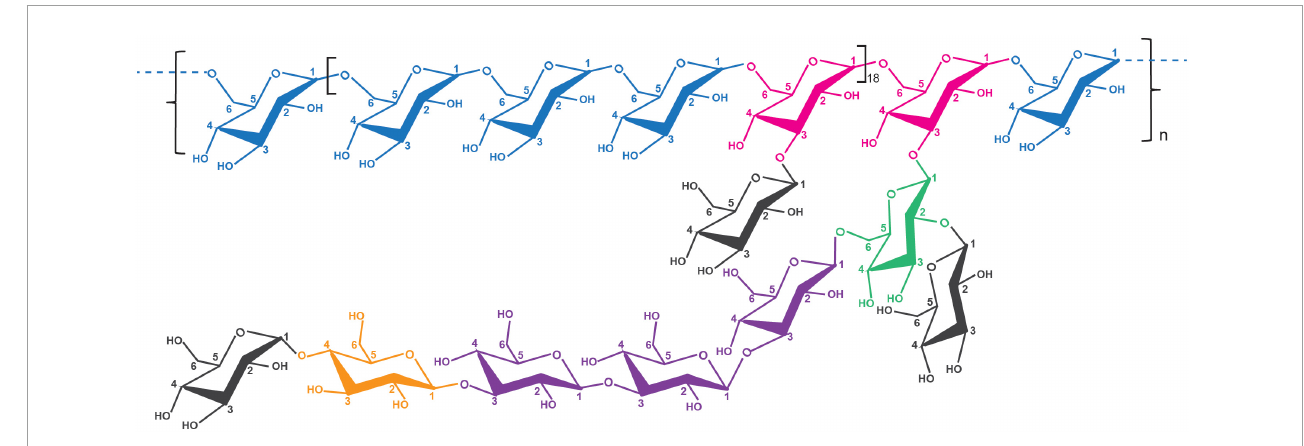
FIGURE5 Proposed chemical structure of RSG7 exopolysaccharide